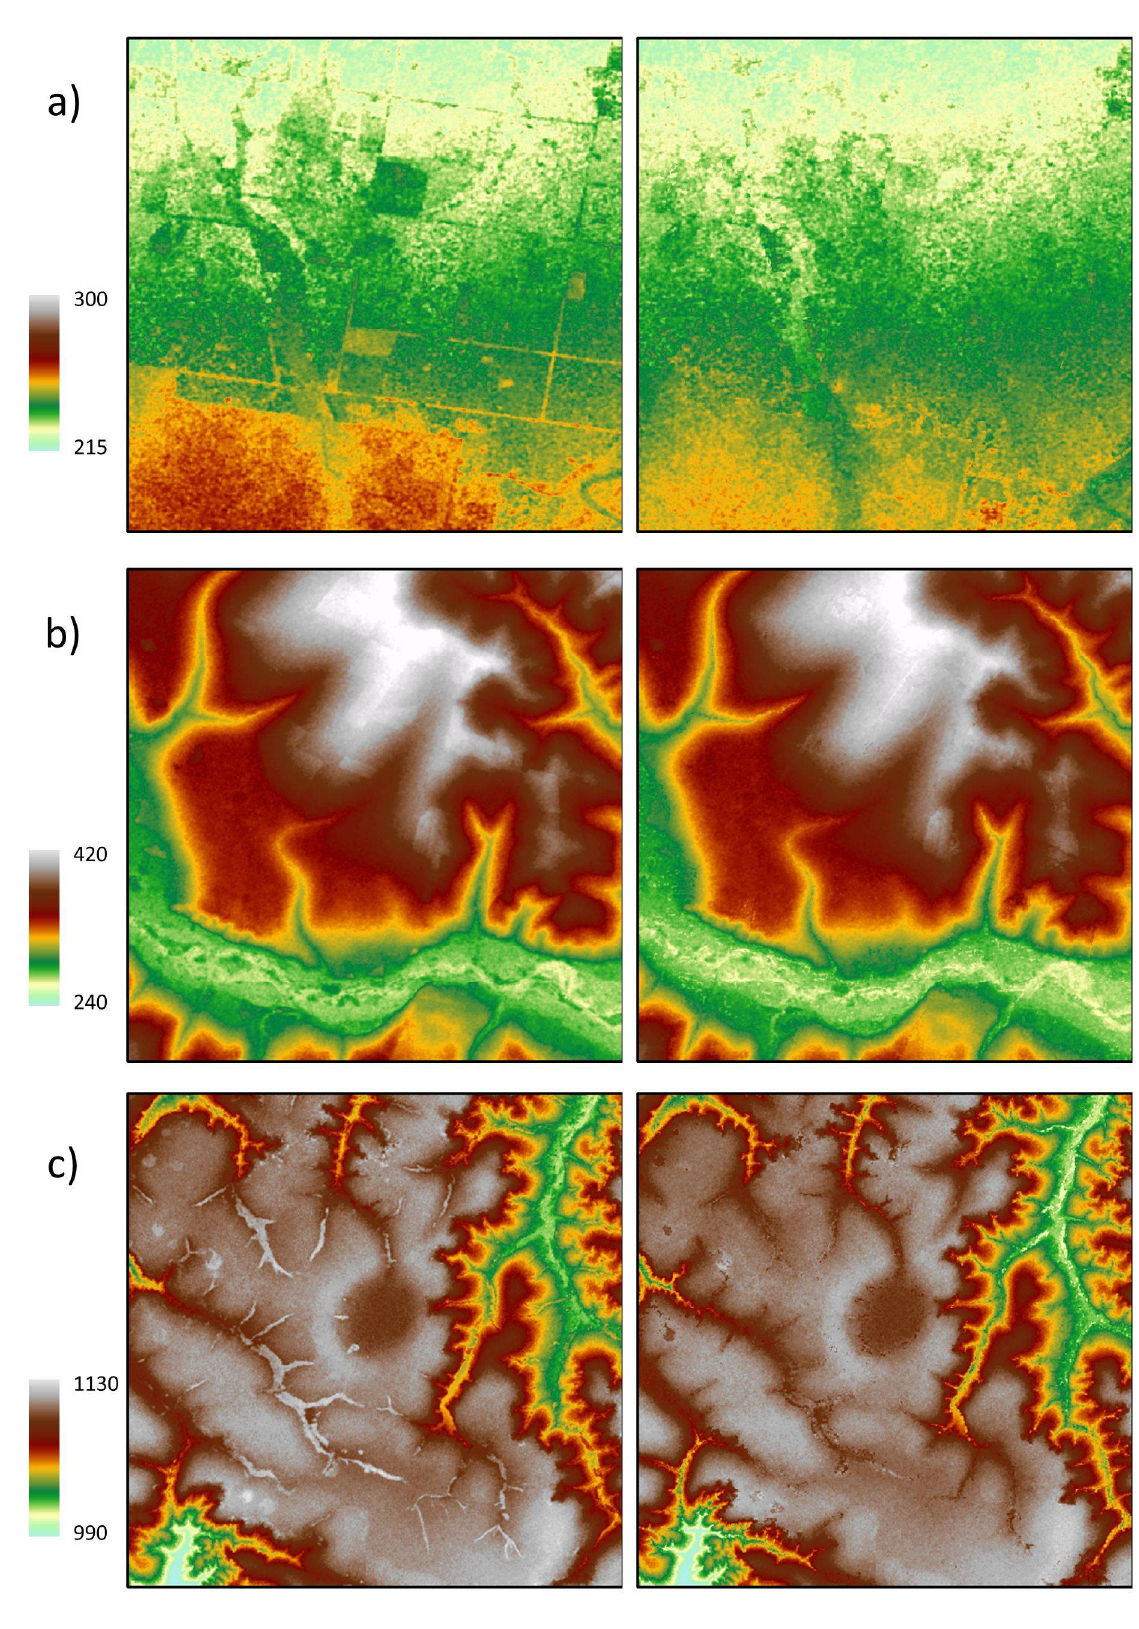
Figure 1. Original SRTM data on the left and after removing tree offsets on the right for a) Eastern Australia (149.6°E, 30.4°S); b) Southern Brazil (52.9°W, 21.6°S); and c) Southern Congo (24.3°E,